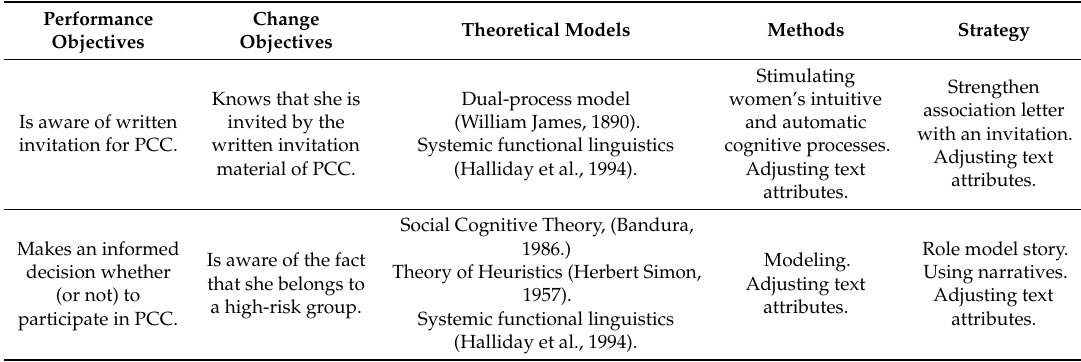
Table 2. Theoretical models, methods and